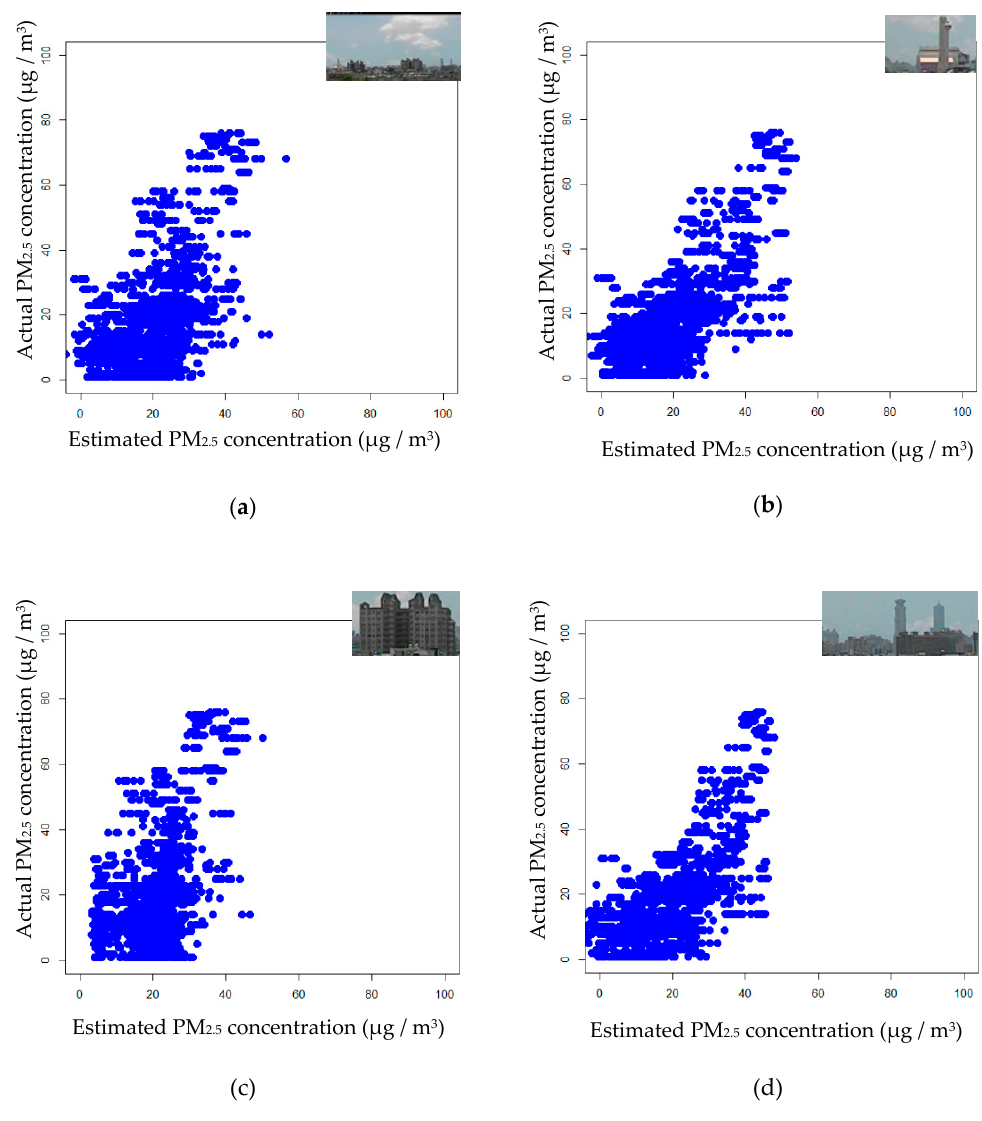
Figure 11. The scatter plots for ( a ) the whole image; ( b ) Region 1 (selected); ( c ) Region 2; ( d ) Region 3. Table 1. The performance indices (with all data).